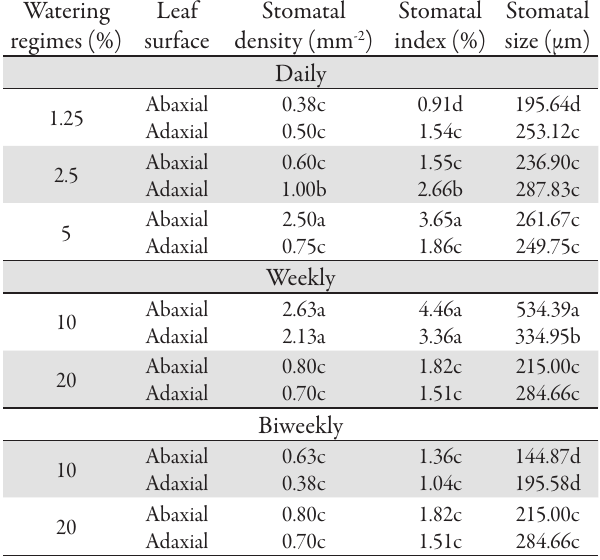
Tab. 5. Stomatal anatomy of Aloe vera raised with different